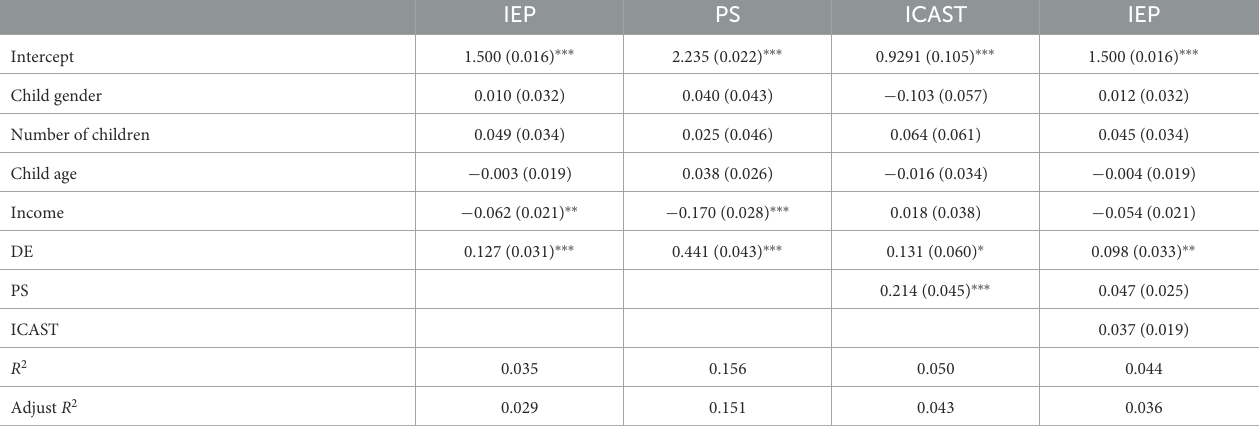
TABLE 2 The regression between parental depression, parenting stress, child maltreatment, and internalizing and externalizing problems ( n = 855). IEP